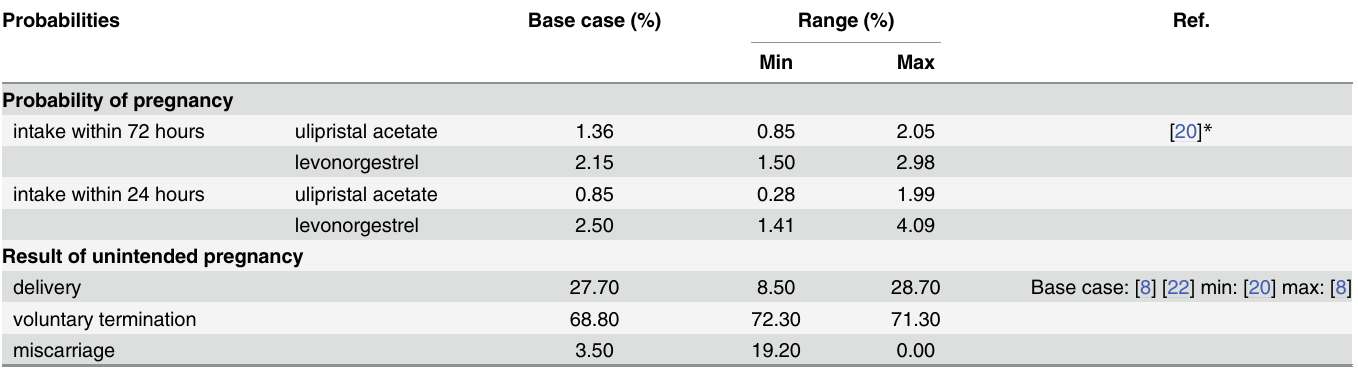
Table 1. Probabilities of pregnancy and pregnancy outcome.